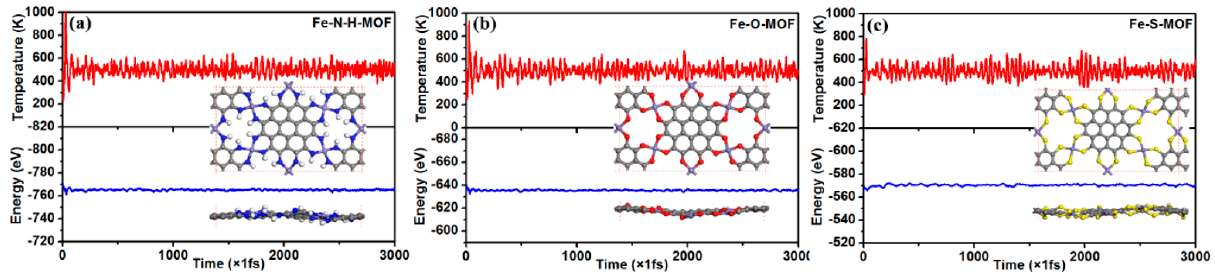
Figure 2. The AIMD simulations of ( a ) Fe-NH-MOF, ( b ) Fe-O-MOF, and ( c ) Fe-S-MOF monolayers at 500 K during the timescale of 3 ps.